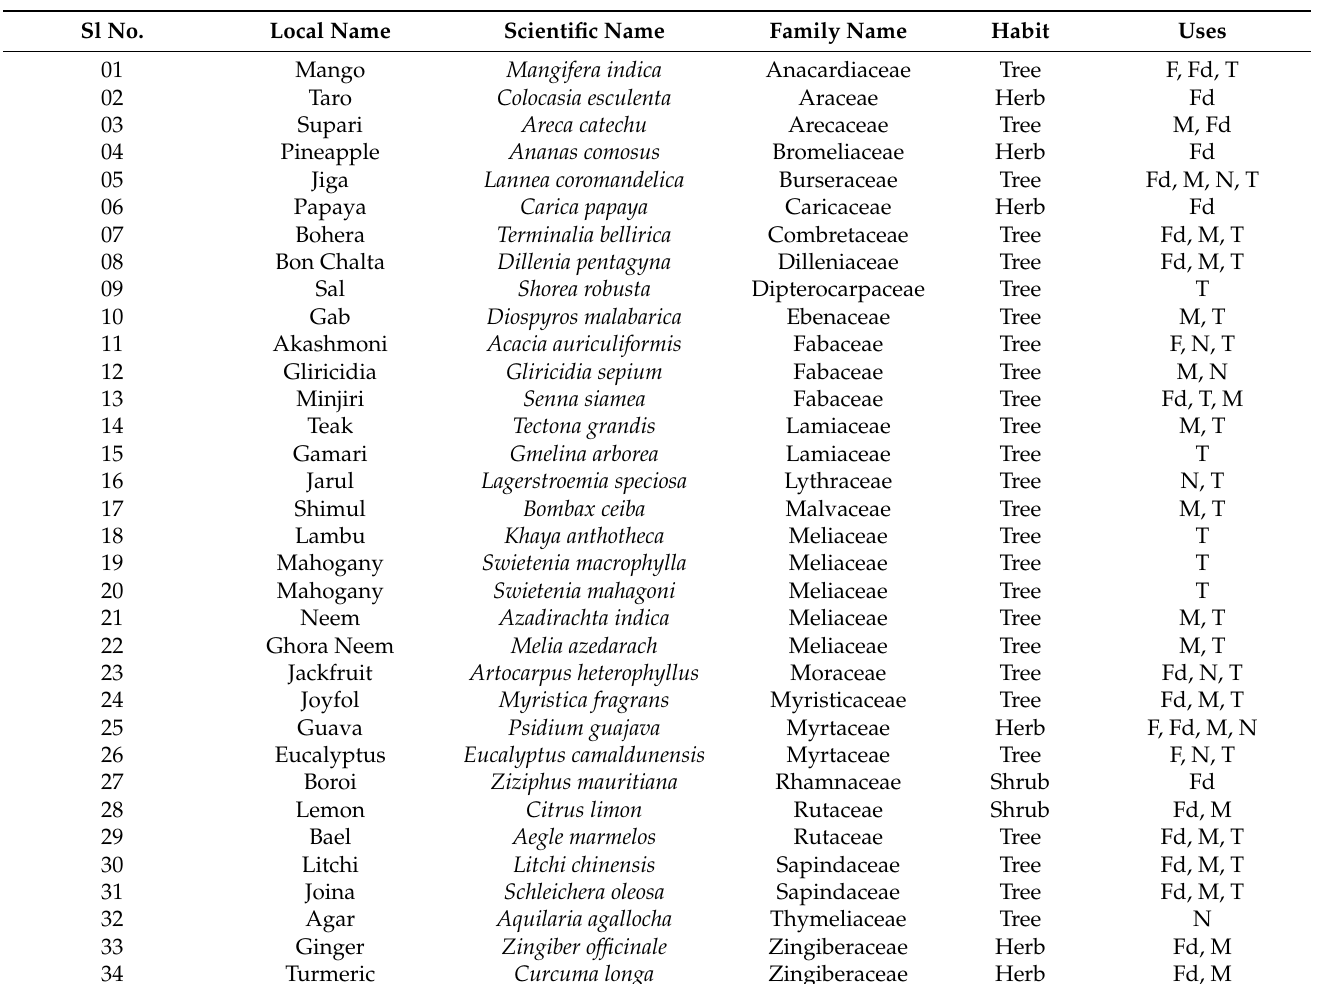
Table 4. Plant species observed in Madhupur tract,